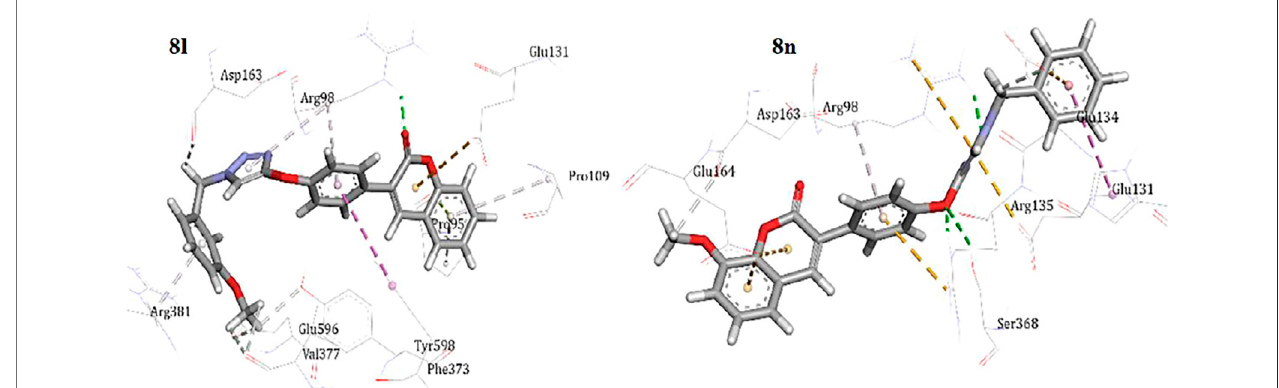
FIGURE 4 | Binding mode of compounds 8l and 8n into the active site of LOX.